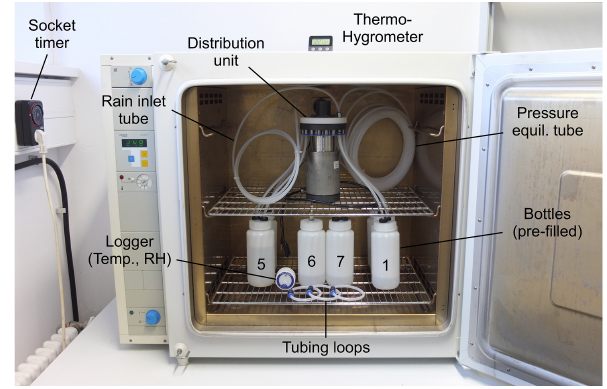
Figure 2. Photograph of the evaporation experiment setup. Note that the bottles were pre-filled with water of known isotopic compo- sition; i.e., no water flowed through the tubing, and the distribution unit did not rotate during the